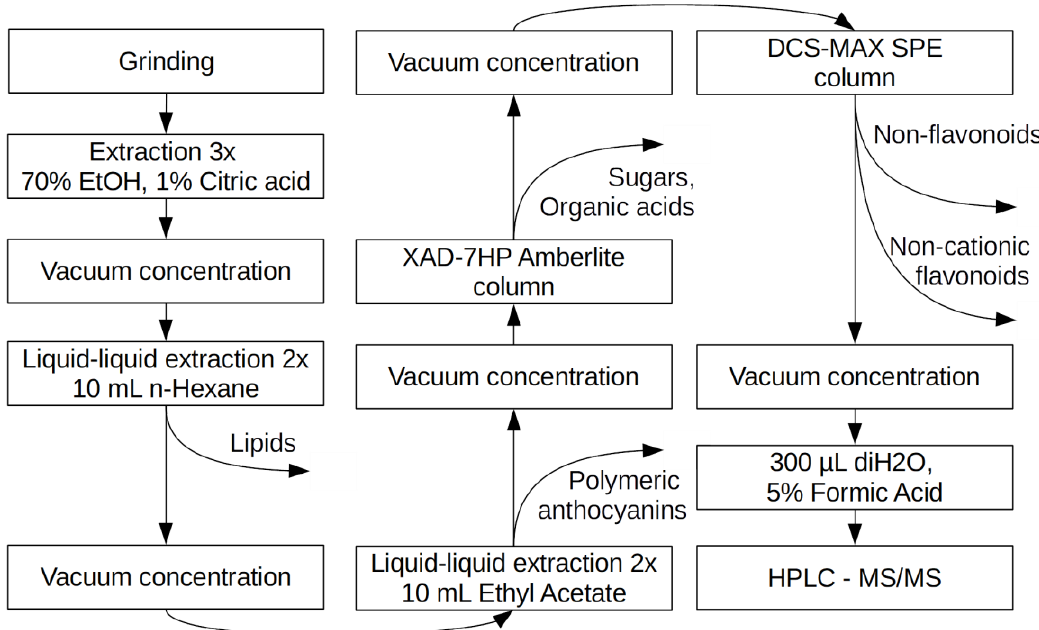
Figure 2. Stages of monomeric anthocyanins purification by selective removal of non-anthocyanin